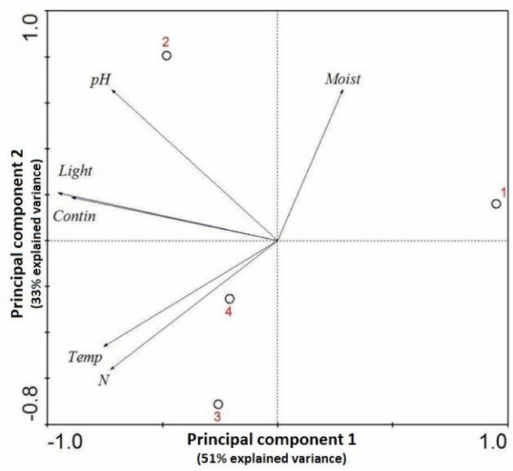
Figure 2. Principal components analysis (PCA) of relationships between Ellenberg indicator values of ground-flora species in di ff erent plots: (1), Tordis (willow); (2), Inger (willow); (3), Pegaso (poplar); and (4), Miscanthus × giganteus . Ellenberg indicator values: Moist, moisture; pH, soil reaction; Light; Contin, continentality; Temp, temperature; and N,